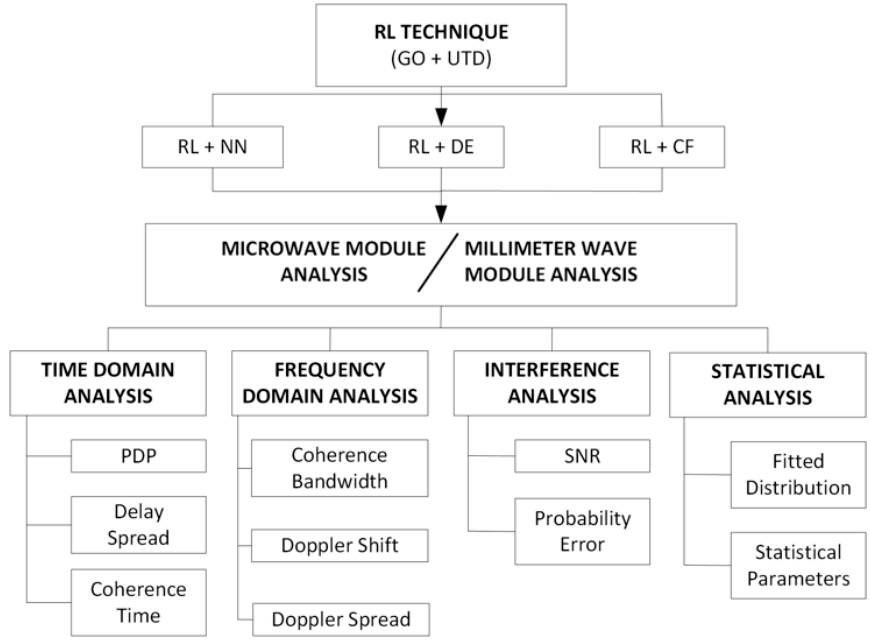
Figure 2. Schematic view of the Three-Dimensional Ray-Launching (3D-RL) algorithm implemented modules.